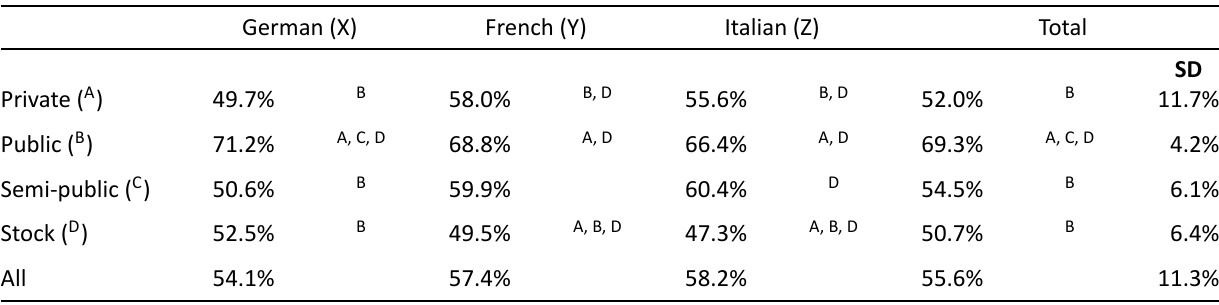
Table 3. Average hard news measures by ownership type and language